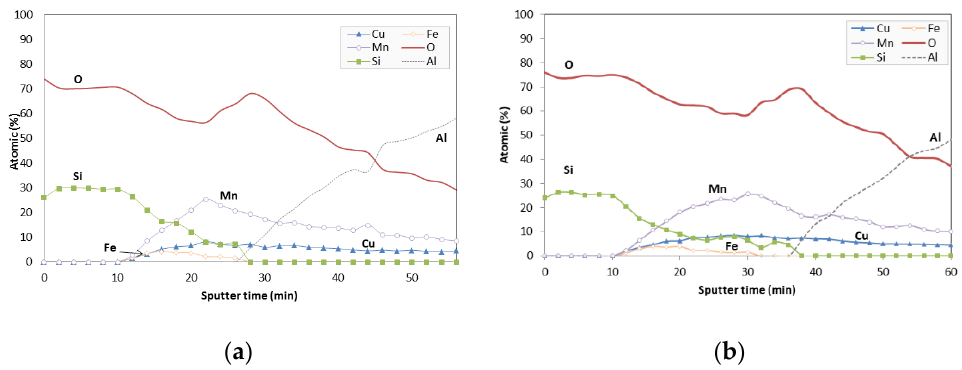
Figure 14. XPS depth profile of the three-layered selective absorber before ( a ) and after 600 h at 40 °C ( b ). Variation of the element concentrations as a function of Ar+ ion etch time.